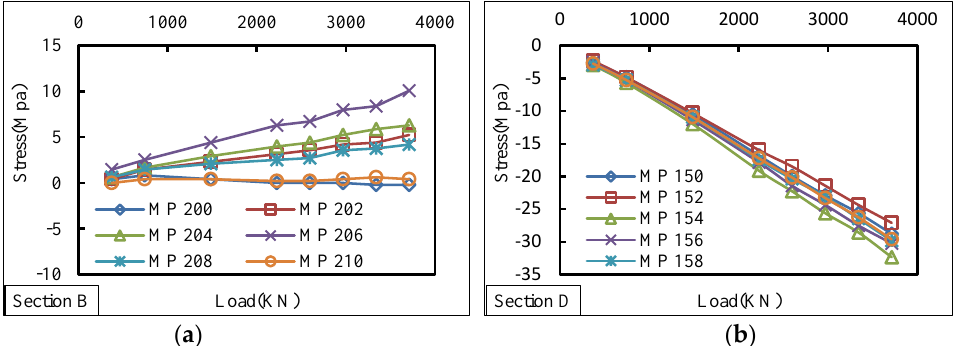
Figure 12. The relationship between load and stress of the steel bars on the bottom slab specimen: ( a ) the upper layer steel of Section B-B; and ( b ) the upper layer steel of Section D-D. MP, measuring point.